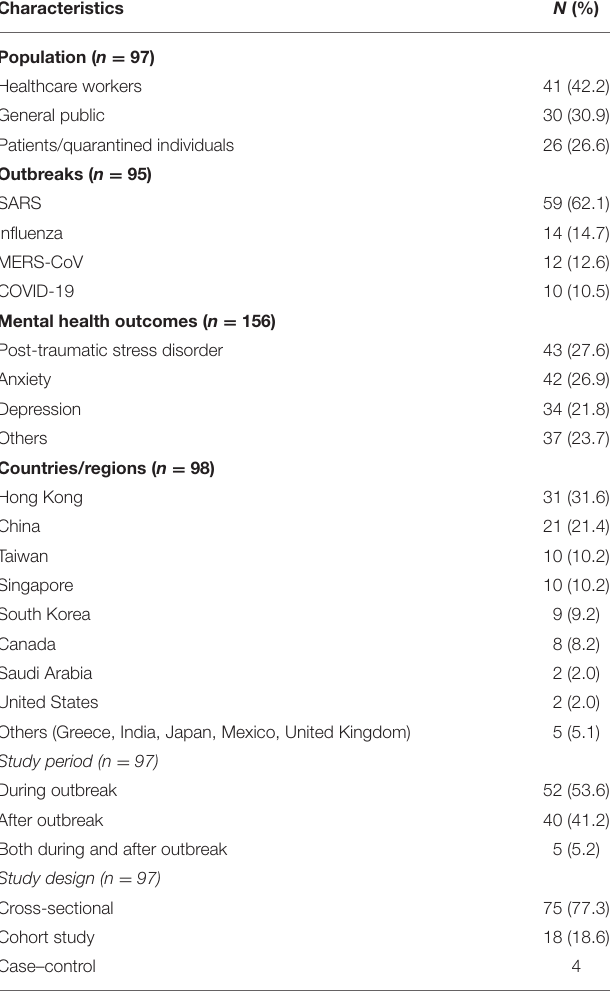
TABLE 1 | Overall study characteristics.